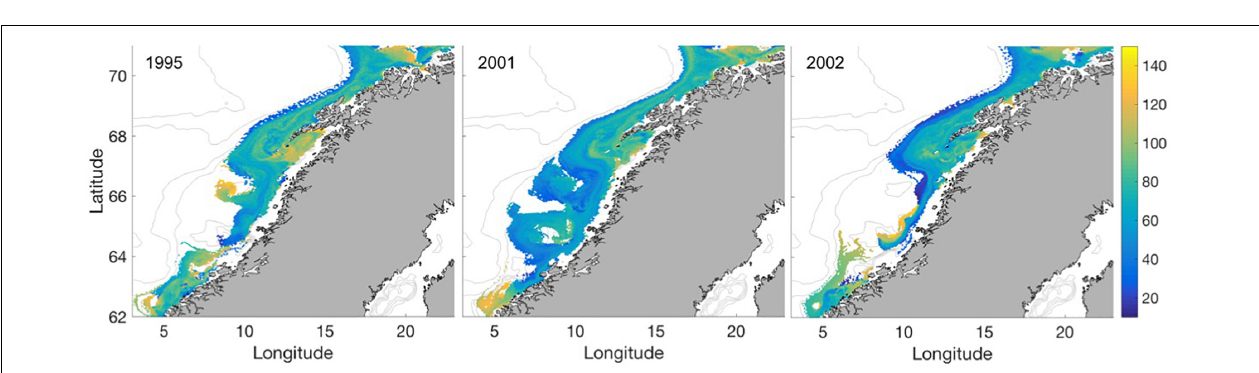
FIGURE 6 | The area-specific fraction of prey-limited growth/non-prey-limited growth for the years 1995, 2001, and 2002. Numbers at 0.2 indicate that there are 5 times more individuals not limited by prey, while 2 indicates that there is 2 times more individuals suffering from prey limitations.